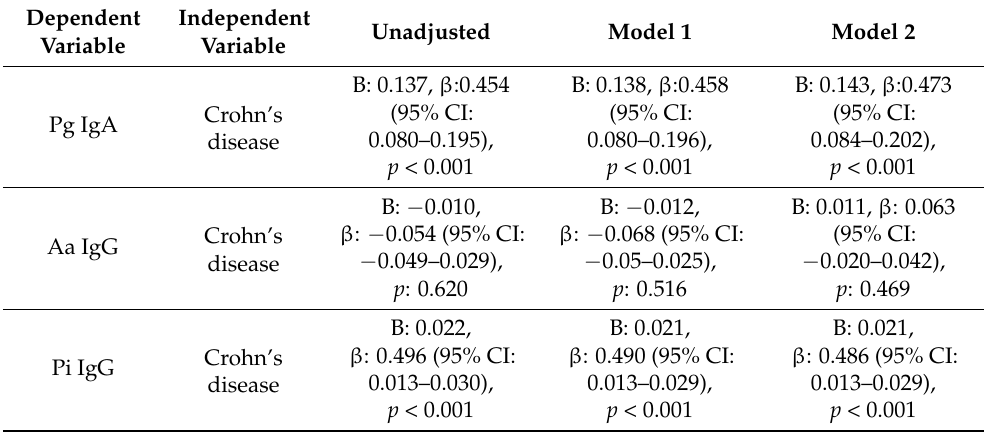
Table 4. Associations of P. gingivalis (Pg) IgA, A. actinomycetemcomitans (Aa) IgG, and P. intermedia (Pi) IgG with Crohn’s disease. Systemically healthy group was taken as the reference. Dependent